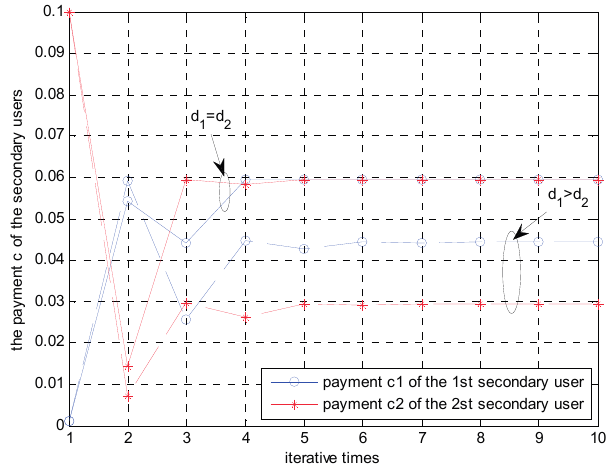
Figure 3. Observation of convergence of relay power c of secondary users for d 1 = d 2 and d 1 > d 2 , where d 1 is the distance between the first secondary user and primary transmitter and d 2 is the distance between the secondary user and primary